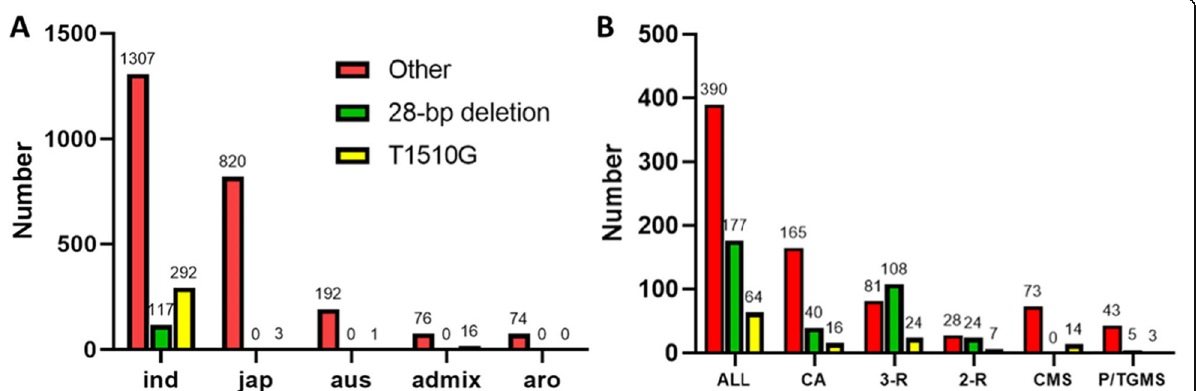
Fig. 3 Comparison of the non-functional alleles of HIS1 in different rice accessions. a Numbers of non-functional alleles of HIS1 in 3000 rice accessions. Ind, indica ; jap, japonica ; aus, aus accessions; aro, aromatic accessions; admix, all other unassigned accessions. b Numbers of non- functional alleles of HIS1 in indica rice accessions collected in this study. ALL, all indica accessions; CA, conventional accessions; 3-R, 3-line restorer; 2-R, 2-line restorer; CMS, 3-line cytoplasm male sterile line; P/TGMS, photoperiod- and thermo-sensitive genic male sterile